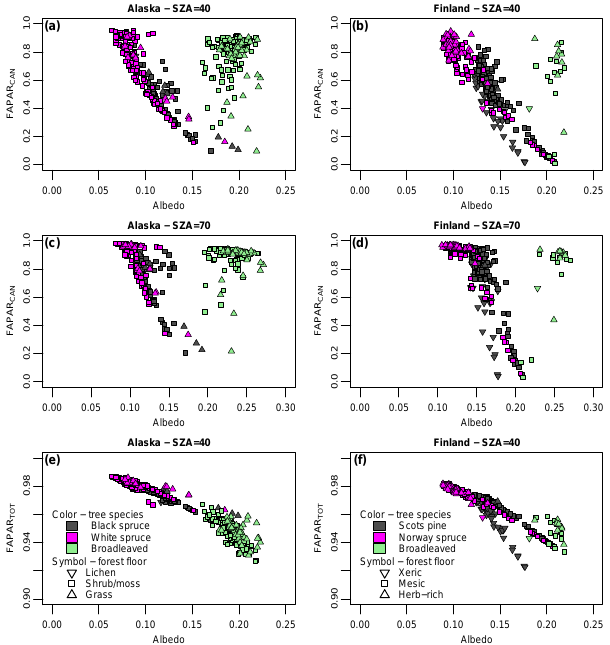
Figure 8. Relation of FAPAR to forest black-sky albedo by domi- nant tree species. The figures show only plots that were dominated by one species, i.e., in which the basal area proportion of one of the species exceeded 80%. (a–d) FAPAR CAN against albedo at two SZAs, 40 ◦ and 70 ◦ , representing solar noon at midsummer and the annual average in the study regions; (e–f) FAPAR TOT against albedo at SZA of 40 ◦ .